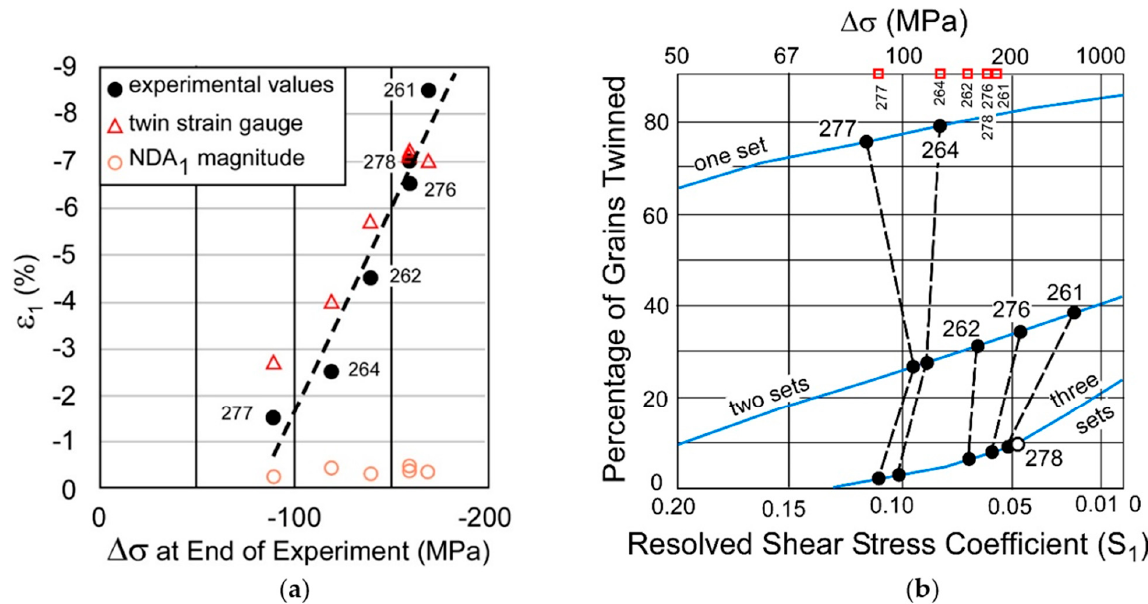
Figure 4. Stress analysis of experimental data. Points are labeled with sample numbers: ( a ) differential stress ( ∆ σ ) vs. strain ( ε ) curve for Indiana limestone deformed at 100 MPa confining pressure, room temperature, and a constant strain rate of 10 − 4 /s (compiled from data in [10,17]. The dashed line is the least-squares best fit to the experimental stress– strain points. The twin strain data have had the 10 largest deviating twin sets removed before calculation. Results from one sample are aligned vertically; ( b ) stress estimated from percentages of twinned grains, compiled from data in [17]. The twin-set percentage curves (blue) are cumulative; the one twin-set curve includes all grains with two and three twin sets. Experimental stress magnitudes are red squares and, in 276 and 278,